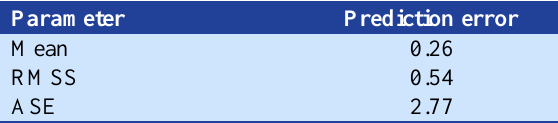
Table 2. Prediction errors of the groundwater phosphate concentrations